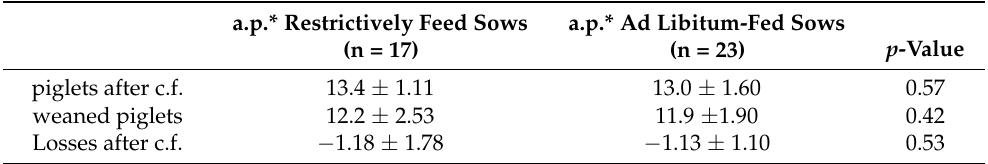
c.f. of both feeding groups.